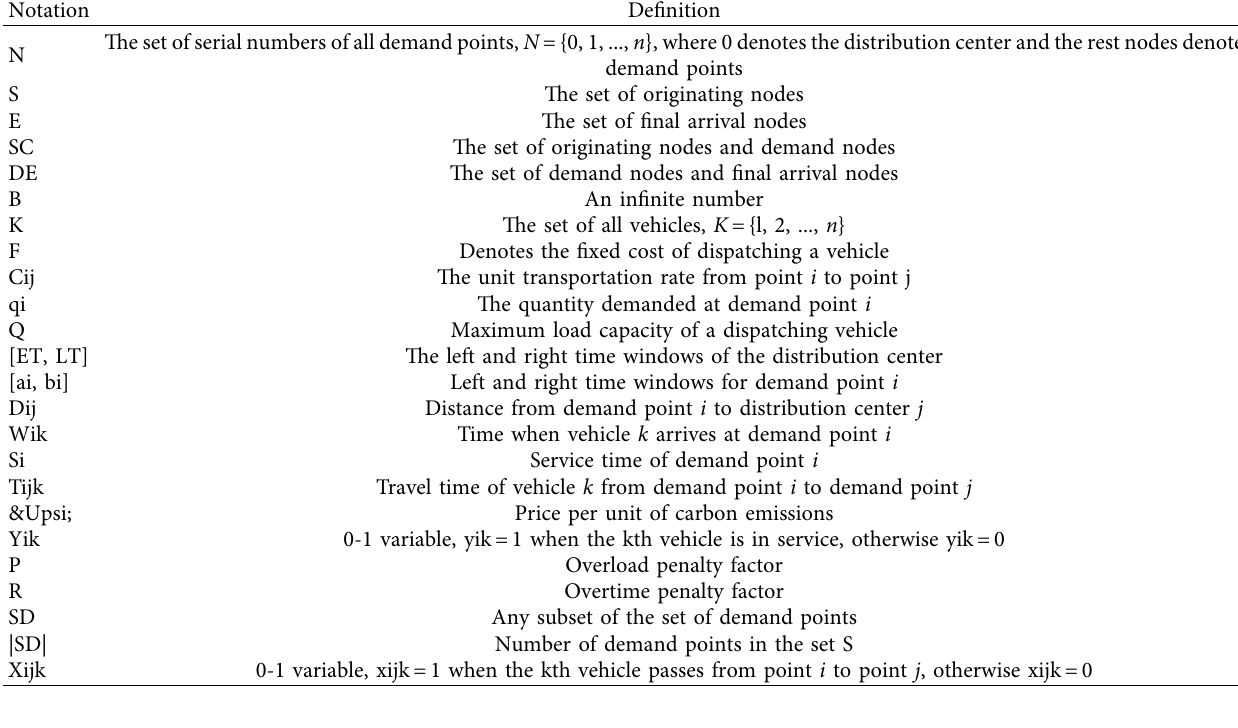
Table 1: Description of symbols for path optimization problems.